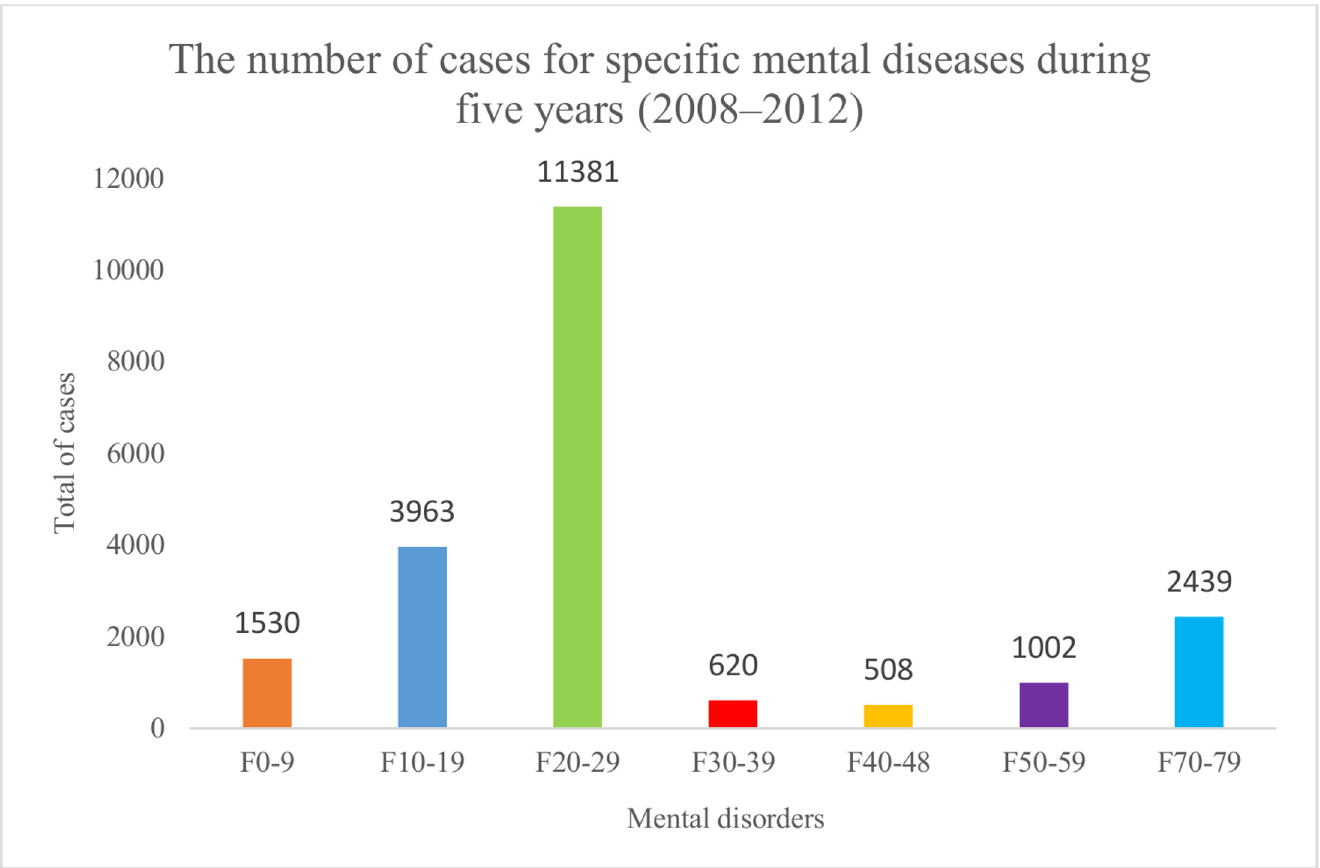
Fig 3. The number of cases for specific mental diseases during five years. The group of F20-29 accounted for the highest hospitalizations (11381), and the group of F40-48 accounted for the lowest admissions (508).